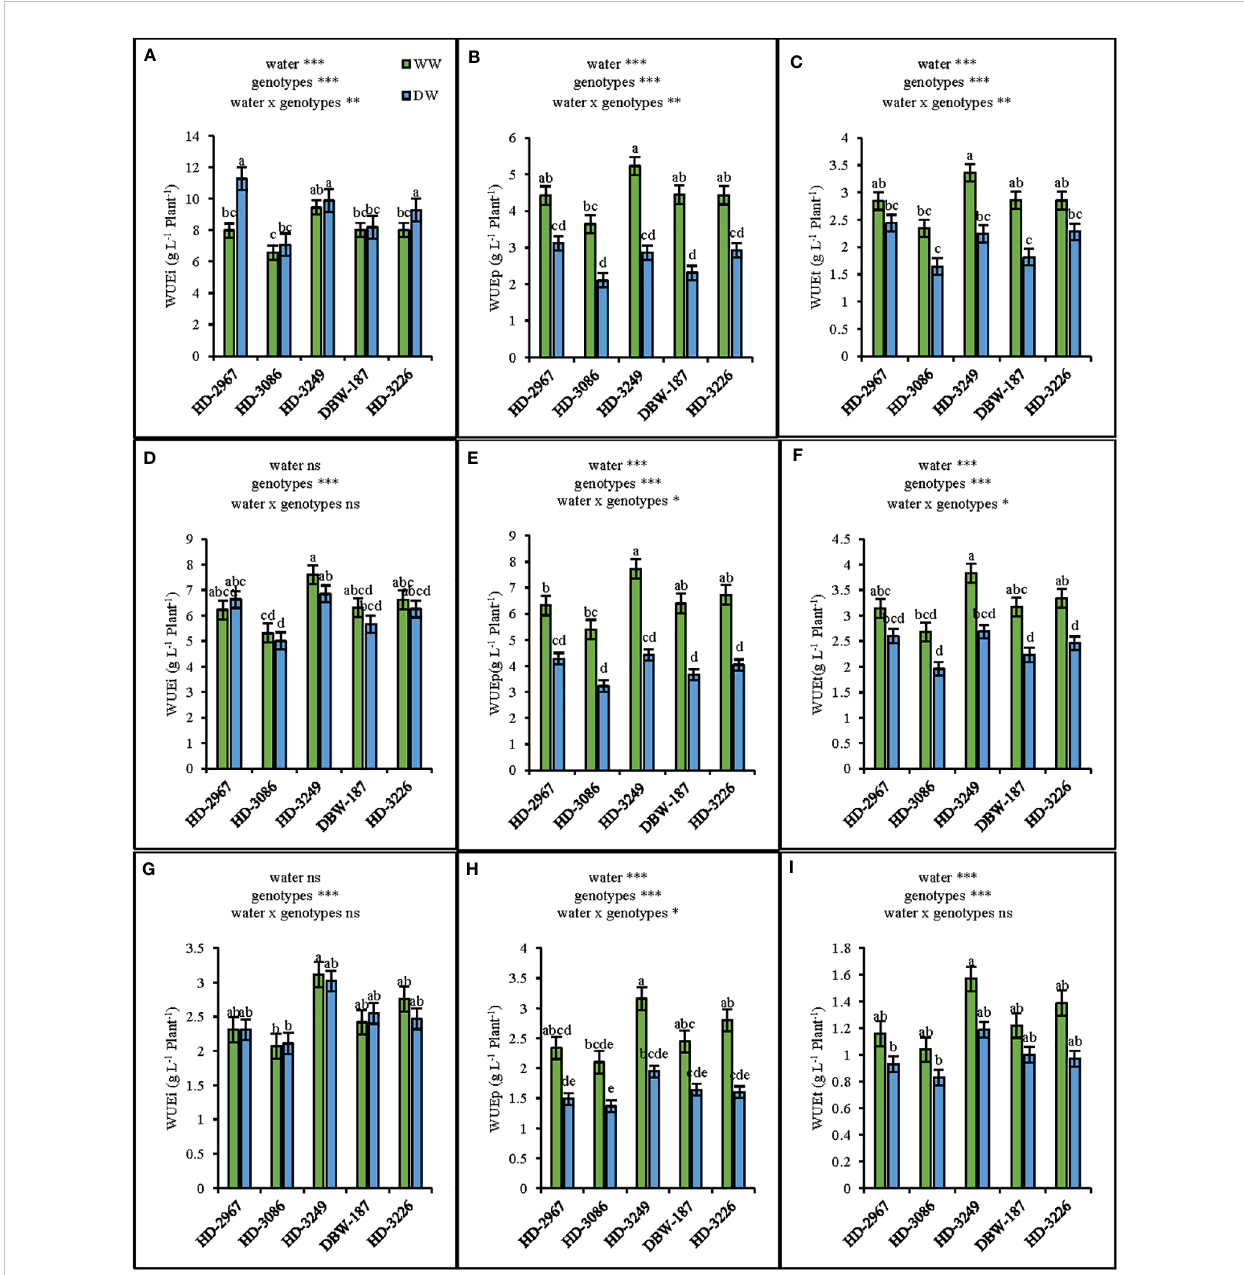
FIGURE 5 Water use ef fi ciencies of fi ve wheat genotypes at fl owering (Z61) and maturity (Z89) grown under wel-(WW) and de fi cit (DW) watered conditions. Dry matter use-ef fi ciency at fl owering (A) : irrigation water use ef fi ciency (WUEi) (B) : precipitation water use ef fi ciency (WUEp); (C) : total water use ef fi ciency (WUEt) Dry matter water use-ef fi ciency at maturity (excluding grain) (D) : irrigation water use-ef fi ciency (WUEi) (E) : precipitation water use ef fi ciency(WUEp); (F) : total water use ef fi ciency (WUEt), Grain water use ef fi ciency (G) : irrigation water use ef fi ciency (WUEi) (H) : precipitation water use ef fi ciemcy (WUEp) (I) : total water use ef fi ciency (WUEt). Letters above the bars indicates signi fi cant difference among genotypes at p<0.05 (Turkey;s HSD test). Signi fi cant at *0.05, **0.01. and ***0.001 probability